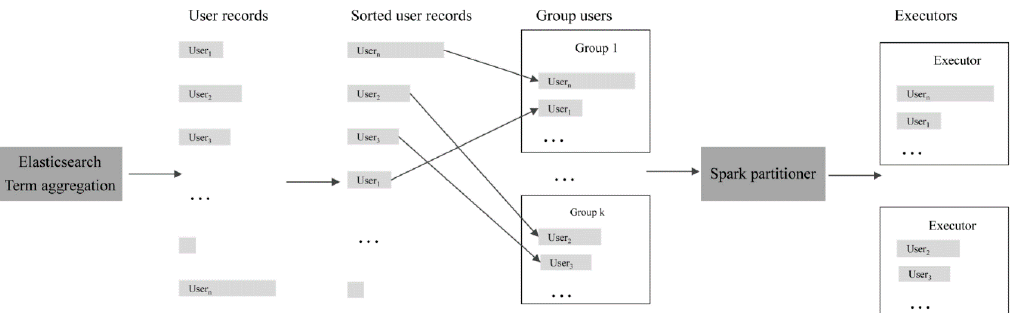
Figure 7. The workflow of the proposed LogPartitioner. Appl. Sci. 2019 , 9 , x FOR PEER REVIEW